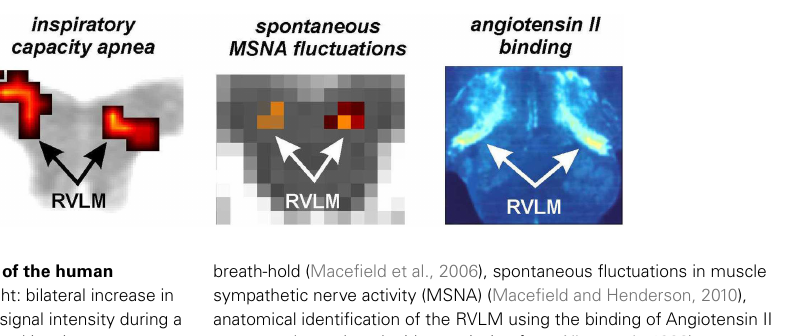
FIGURE 6 | Functional and anatomical localization of the human rostroventrolateral medulla (RVLM) . From left to right: bilateral increase in RVLM functional magnetic resonance imaging (fMRI) signal intensity during a sustained muscle ischemia (Sander et al., 2010), maximal inspiratory